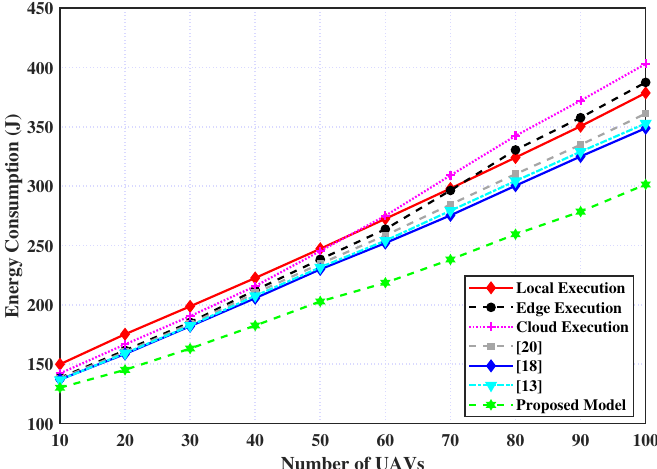
Figure 5. Energy consumption over number of UAVs.